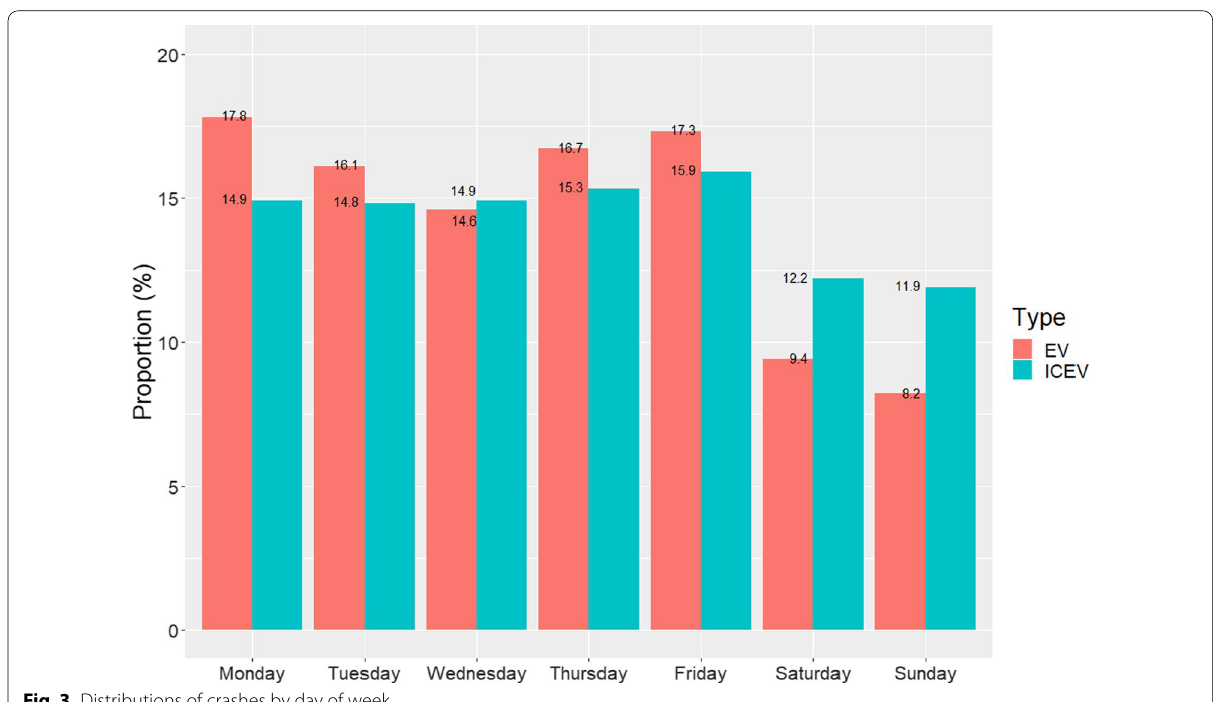
Fig. 3 Distributions of crashes by day of week